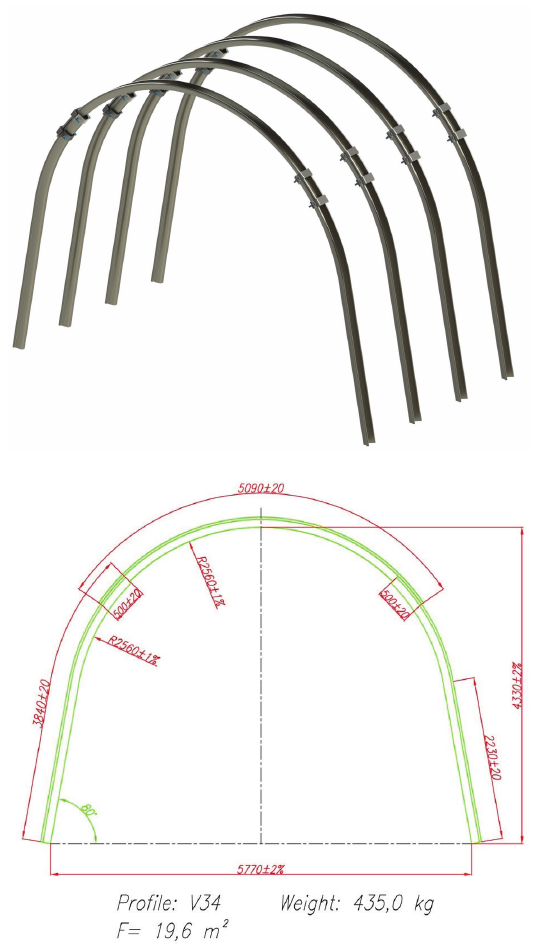
Figure 3: The shape of the frame and basic geometrical parameters.